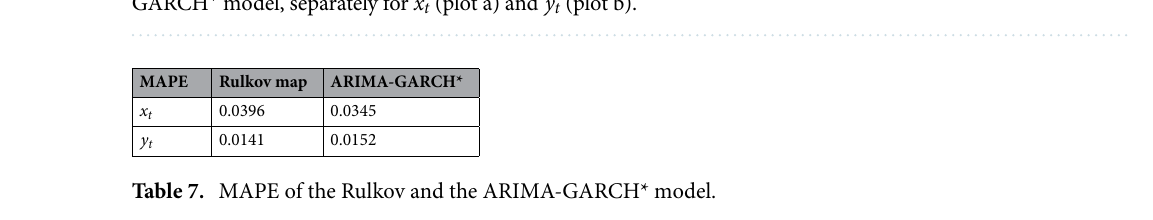
Figure 7. Absolute percentage error between the forecasts produced by the Rulkov map and the ARIMA- GARCH ∗ model, separately for x t (plot a) and y t (plot b).